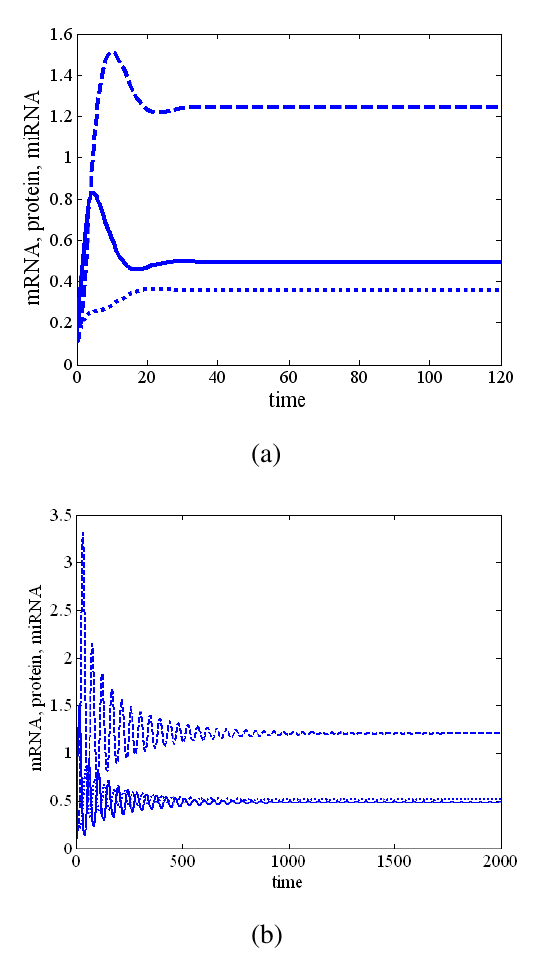
Fig. 3. Stable regime of system (2) for a) τ 1 = τ = τ = 0 and b) for τ 2 3